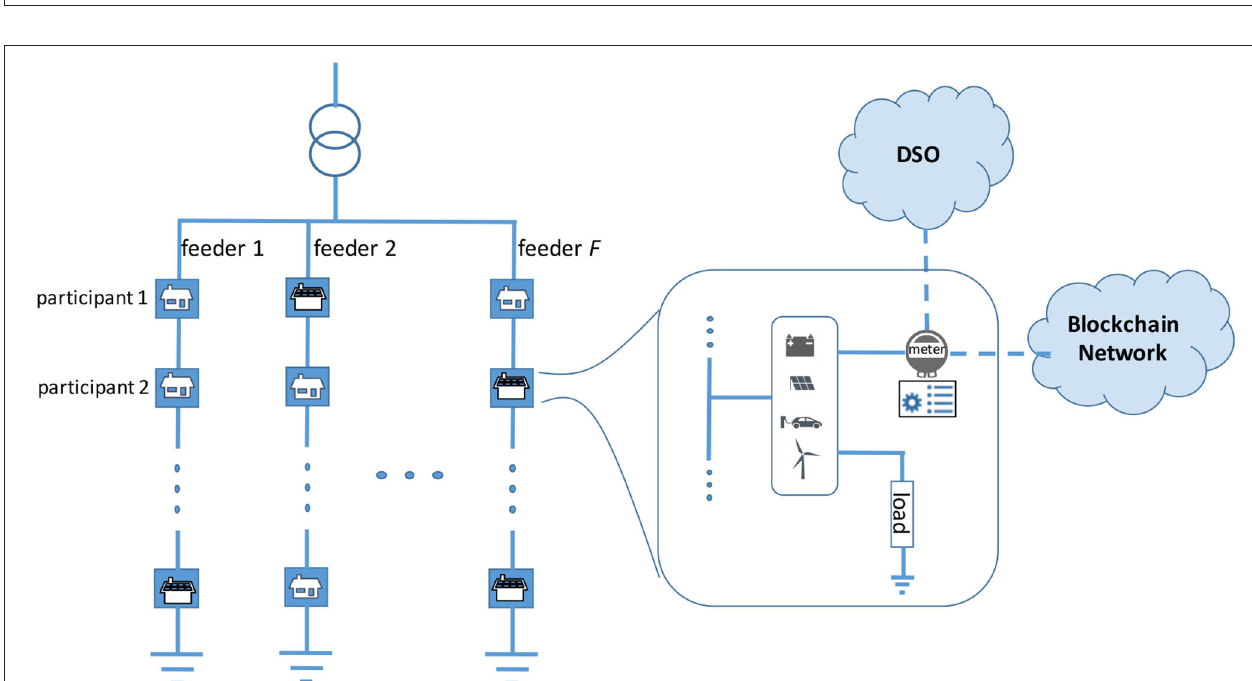
FIGURE 2 | A multi-feeder microgrid example of a transactive energy system.